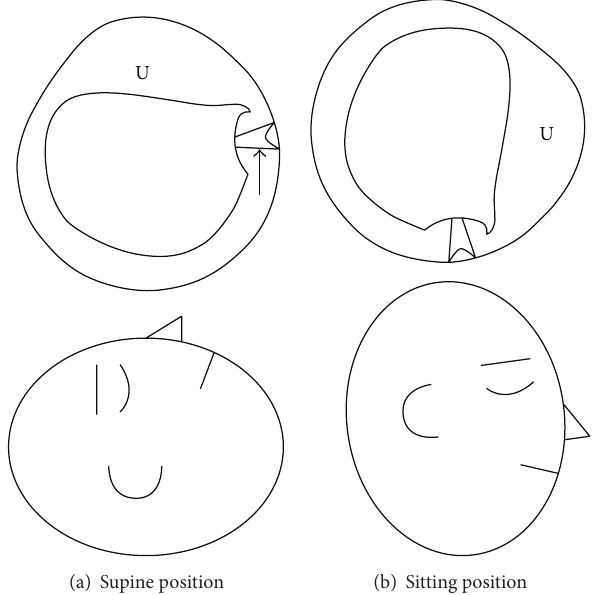
Figure 2: A light cupula of the right posterior semicircular canal. Arrows indicate the deflection of the cupula. U: